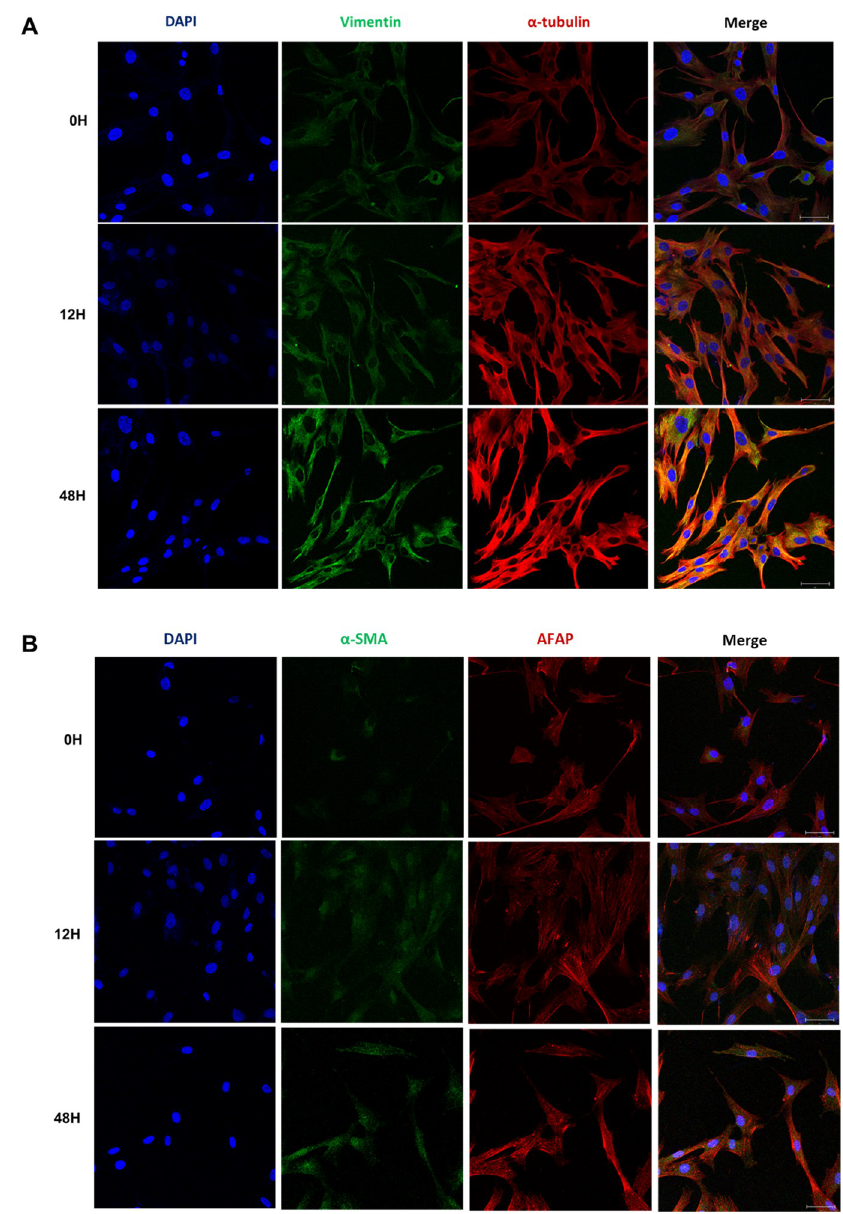
Figure 5. Expression of phenotypic markers of EMT under hypoxia. (A) Immunofluorescence analysis of vimentin and α-tubulin in HDFs under hypoxia for 12 h. (B) Immunofluorescence analysis of alpha-smooth muscle actin (α-SMA) and actin filament-associated protein 1 (AFAP) under hypoxia for 12 h; DAPI (blue), vimentin (green, upper), α-SMA (green, lower), α-tubulin (red, upper), AFAP (red, lower). Results are representative of three independent experiments, scale bar = 50 μM.